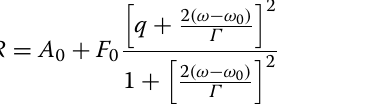
where A 0 and F 0 are constant factors, q is the asymmetry parameter (different from the asymmetry parameter, α of the Fano structures) which determines the ratio between resonant and non-resonant state, ω 0 is the resonance fre- quency and Γ is the full-width at half maximum of the res- onance frequency. In the context of this work, Q -factor is defined as the ratio between the resonance frequency and the full-width at half maximum of the resonance dip in the